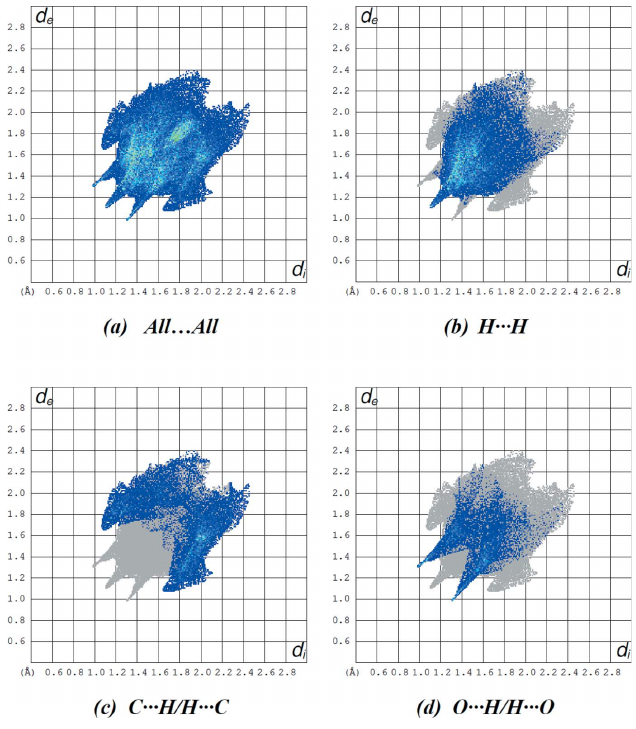
Figure 5 A view of the two-dimensional fingerprint plots for the title compound, showing ( a ) all interactions, and delineated into ( b ) H (cid:2)(cid:2)(cid:2) H, ( c ) C (cid:2)(cid:2)(cid:2) H/ H (cid:2)(cid:2)(cid:2) C and ( d ) O (cid:2)(cid:2)(cid:2) H/H (cid:2)(cid:2)(cid:2) O interactions. The d i and d e values are the closest internal and external distances (in A˚ ) from given points on the Hirshfeld